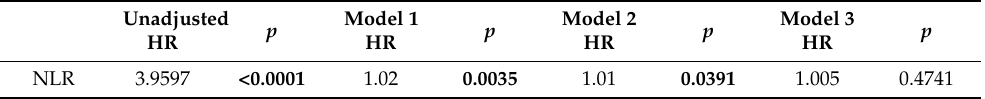
Table 4. Cox regression models predicting ICU admission. Model 1: adjusted for sex and age. Model 2: adjusted for comorbidities. Model 3: adjusted for